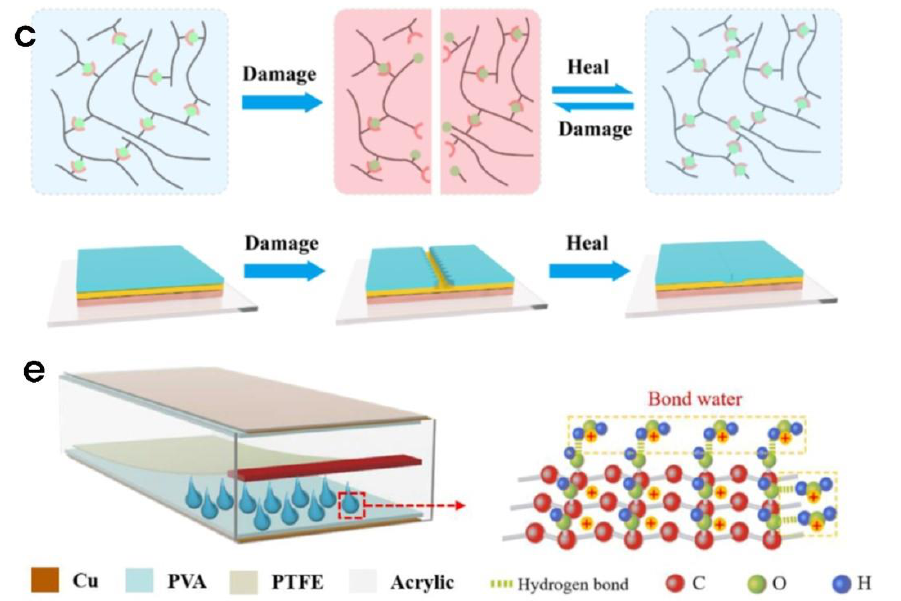
Figure 14. ( a ) (I) the structure diagram of the GO-CC-TENG. (II)the manufacturing diagram of the GO-CC-TENG. (III), (IV) the picture of the synthetic go-collagen/cellulose membrane and the GO- CC-TENG [23]. Liu et al. (2022), Elsevier. ( b ) The upper part is the schematic diagram of the manufac- turing process of the Mao/FSG coating, and the lower part is the SEM image of the Mao/FSG coating and the schematic diagram of the MF-TENG [97]. Liu et al. (2022), CNKI. ( c ) Schematic representation of the molecular level repair mechanism of linear silicone-modified polyurethane. ( d ) Schematic diagram of the PU-based linear silicone-modified self-healing TENG [98]. Sun et al. (2022), ACS. ( e ) Schematic diagram and mechanism diagram of the PTFE-based flexible TENG for collecting wind energy and moisture resistance [99]. Sun et al. (2021),